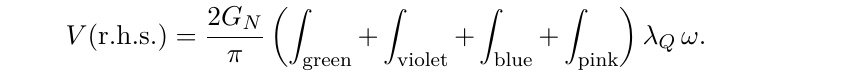
. Color coding 3 , i.e. its intersection Q . Its sectors are color-coded Q ⊂ K